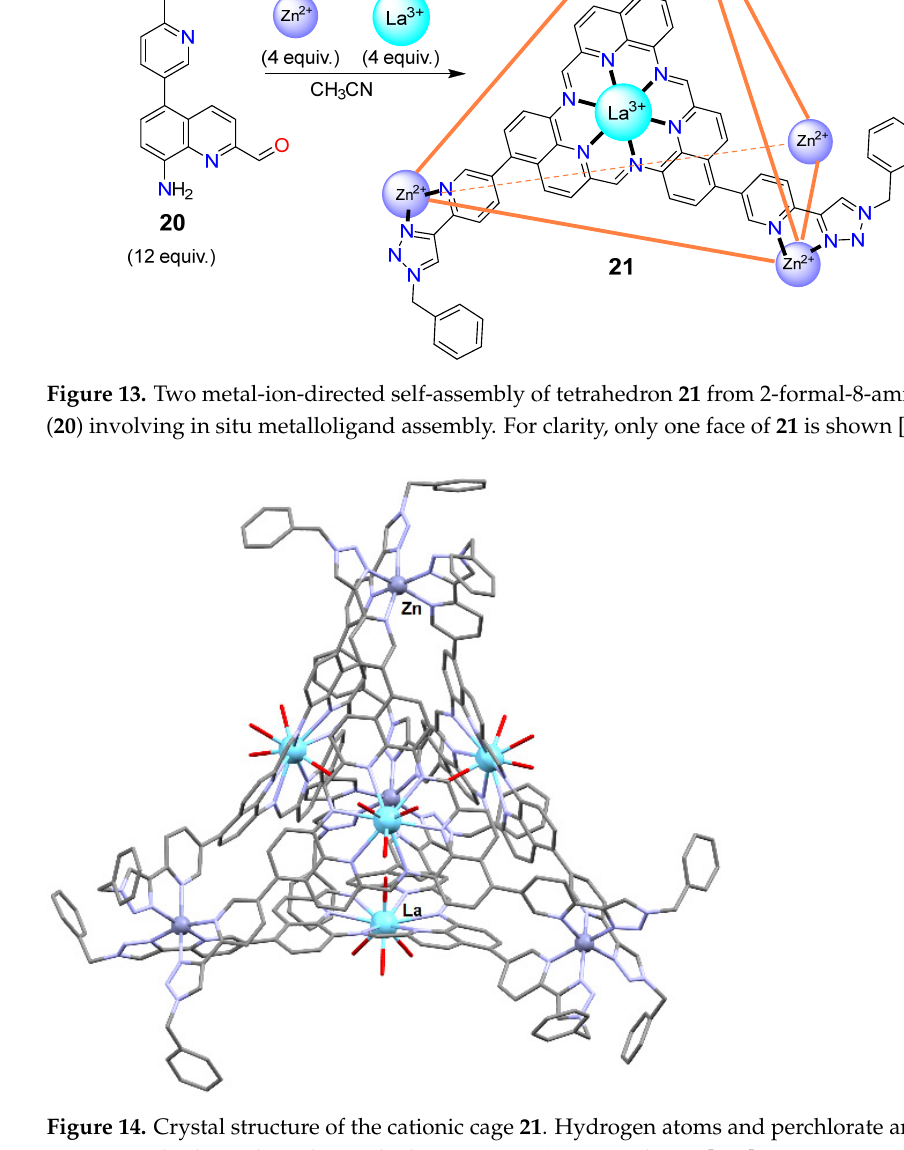
Figure 13. Two metal-ion-directed self-assembly of tetrahedron 21 from 2-formal-8-aminoquinoline ( 20 ) involving in situ metalloligand assembly. For clarity, only one face of 21 is shown [122].